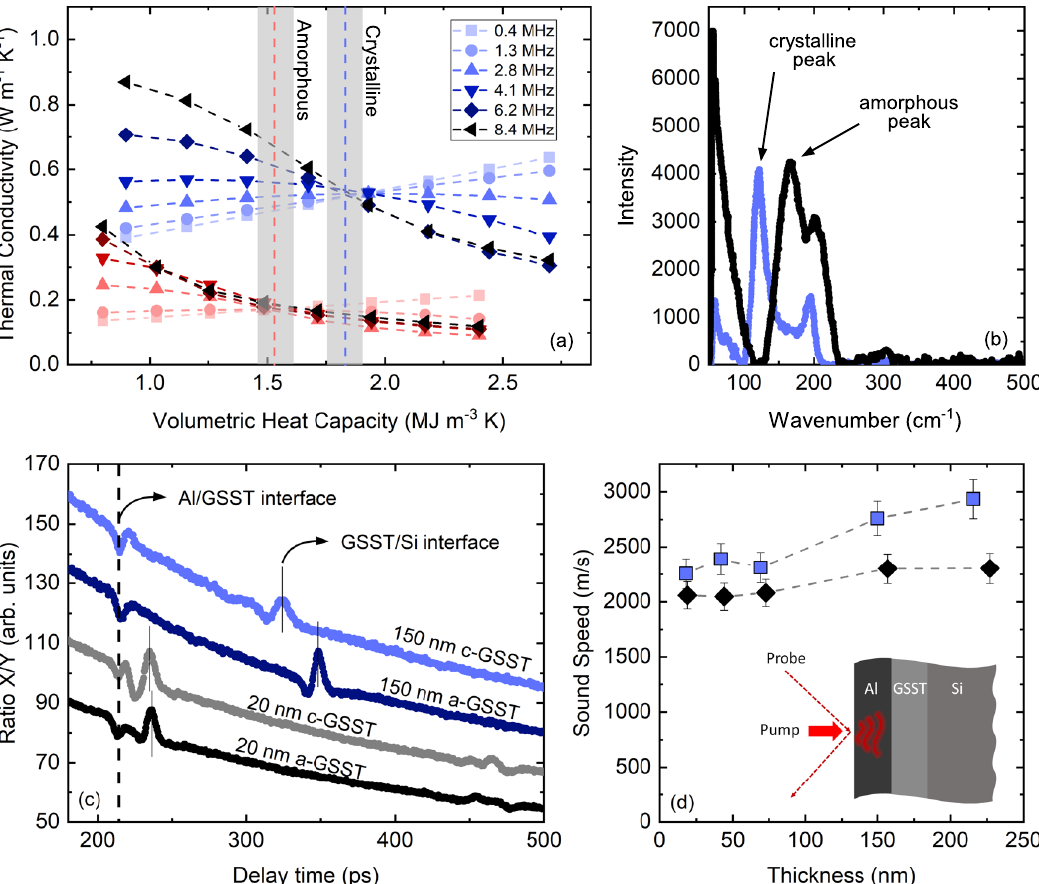
Fig. 2 Thermophysical properties of GSST upon phase transformation. a GSST volumetric heat capacity for amorphous and crystalline (annealed at 300 °C) phases measured with TDTR at different modulation frequencies. The gray area corresponds to the uncertainty of the measurements. b Raman spectra for GSST showing the amorphous and crystalline peaks, c picosecond acoustics measurements and the corresponding echoes from the interfaces, d sound speed for different thicknesses of GSST in amorphous (black diamonds) and crystalline (blue squares) phase. The uncertainty is calculated based on 10% variation in GSST fi lm